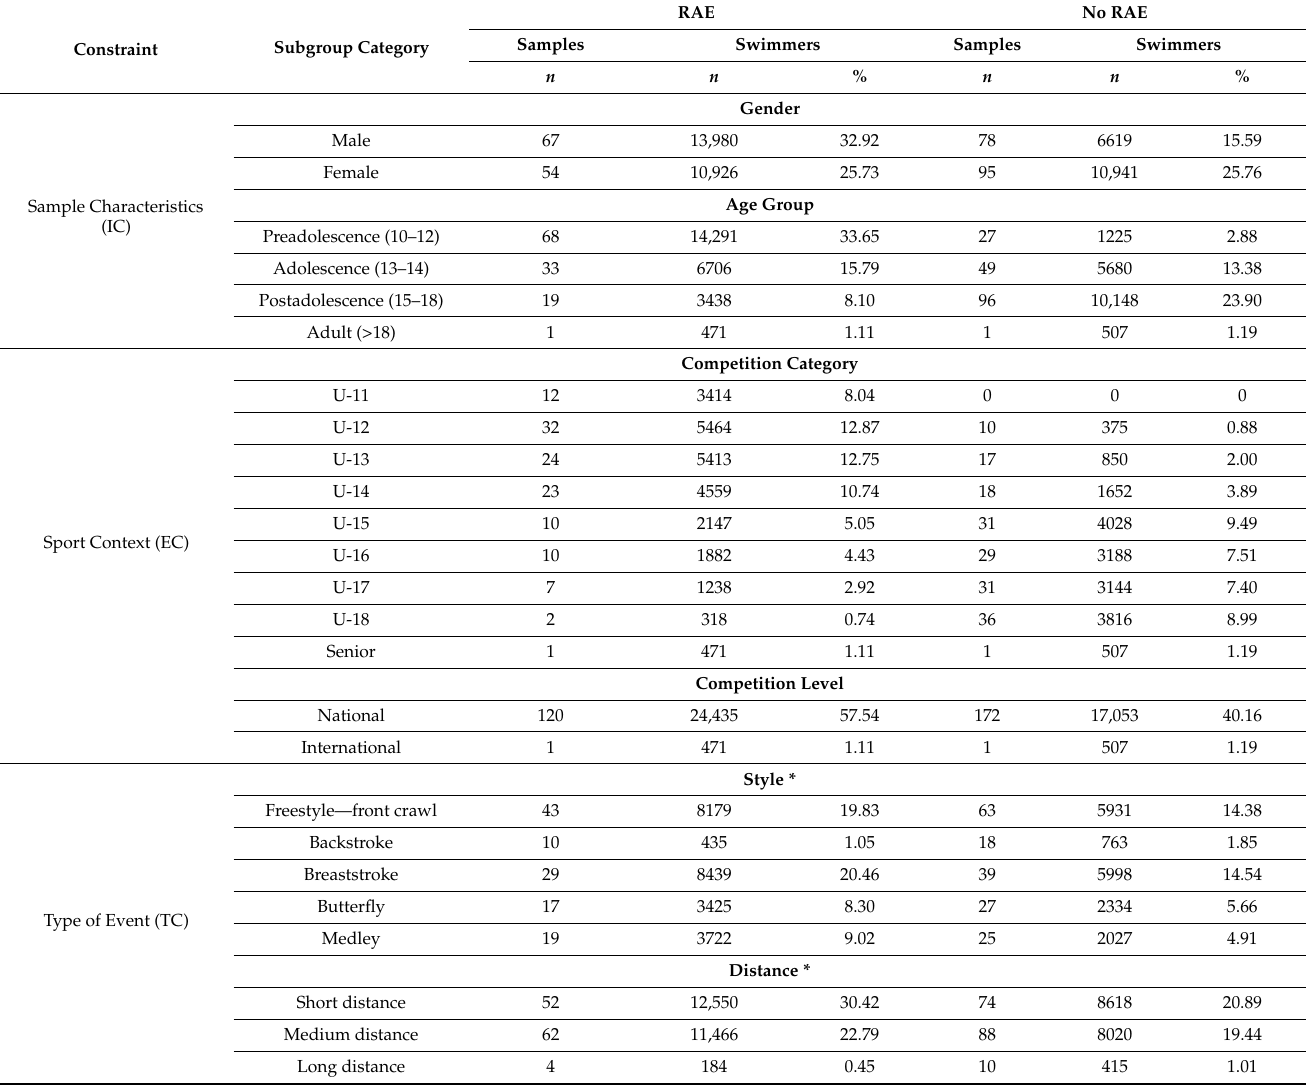
Table 3. Summary of the sample’s distribution ( n and %) according to the relative age effect (RAE or no RAE) by characteristics of swimmers (gender and age group), sport context (competition category and competition level), and type of event (style and